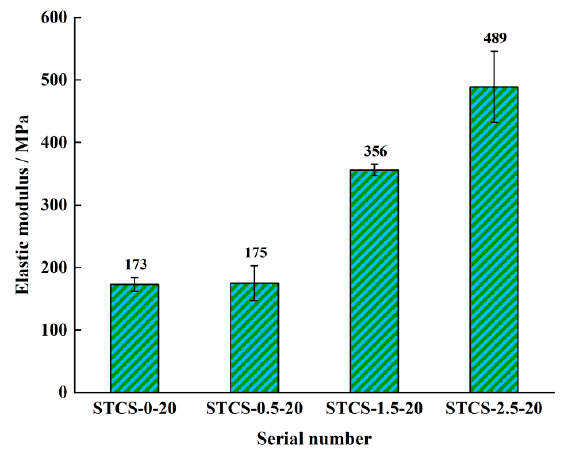
Figure 13. Elastic modulus of STCS.